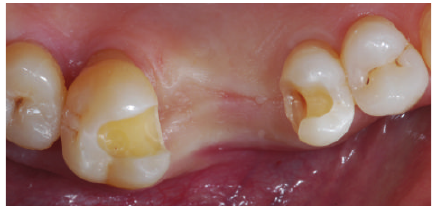
Figure 2: Standardized inlay preparations; previous composite fillings were